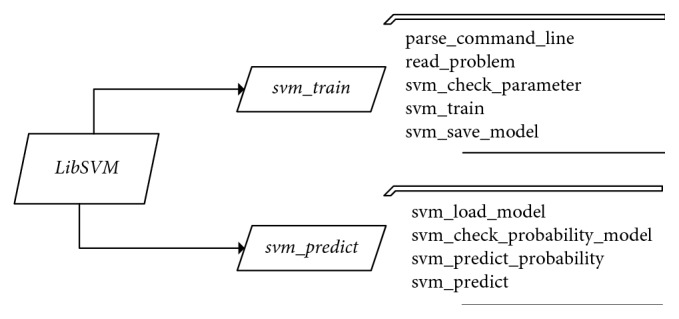
Hierarchy of the methods in LibSVM [23].